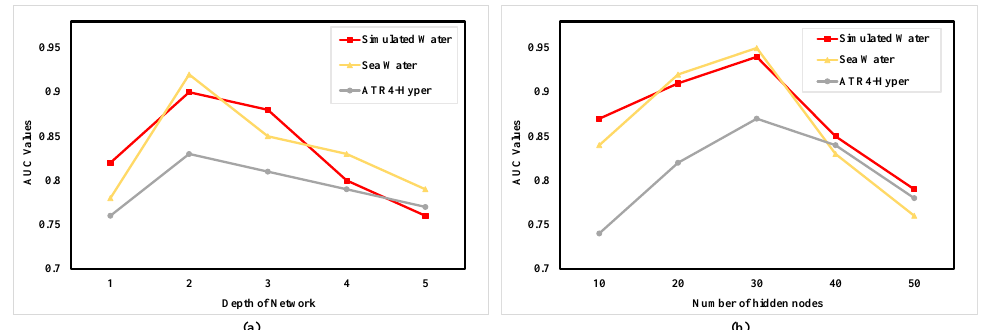
Figure 8. Network parameter analysis of the autoencoder on different datasets. ( a ) Network depth and ( b ) number of hidden